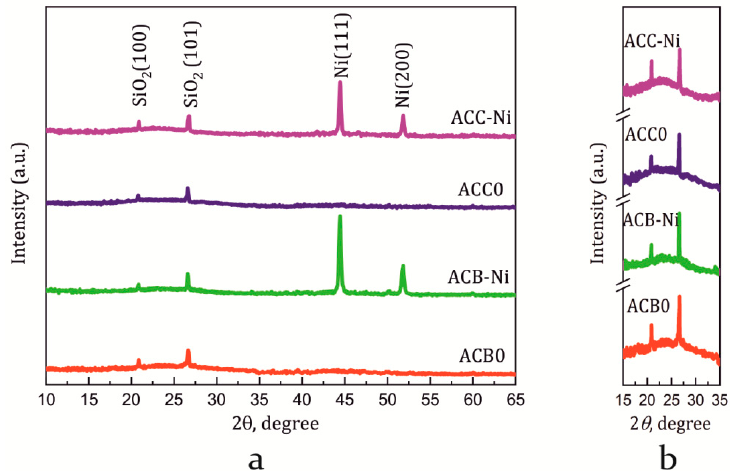
Figure 1. SEM images of ACB0 ( a ), ACC0 ( c ) carbons, ACB-Ni ( b ), and ACC-Ni ( d ) Ni/C composites. Figure 2. XRD patterns of pure carbons (ACB0, ACC0) and Ni/C magnetic composites (ACB-Ni, ACC-Ni) ( a ), and zoom-in view ( b ).